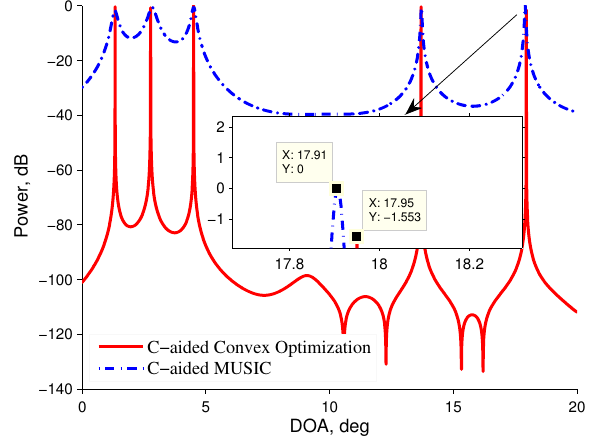
Figure 2. DOA estimation result of proposed algorithms ( M AI = M AII = 500,SNR = 20